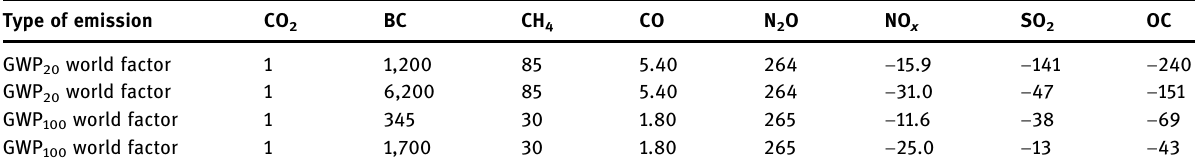
Table 1: Potential of global warming per fuel type in kg - CO 2 - equivalents/kg emission [ 27 ]